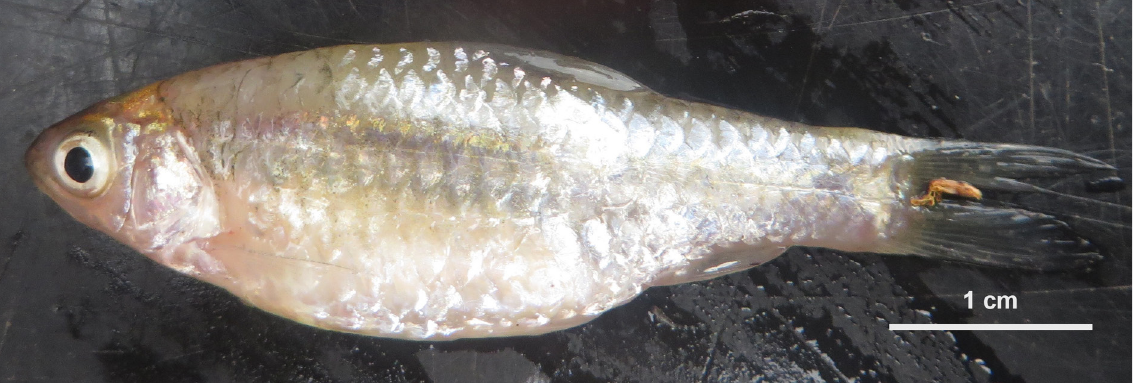
Fig. 9. Fresh specimen of E. cf. mimus (Boulenger, 1912) (RMCA 2016.035.P.0125-0139 HP547) with 45.2 mm